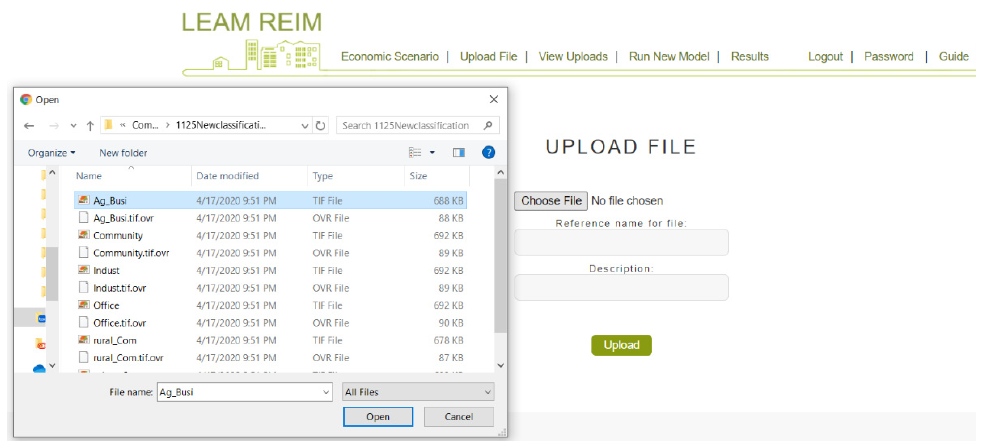
Figure 3. LEAM-REIM interface for uploading files. Users click “choose file” button to choose file from local portals to upload the model input files. A file name and description are required as notes for future use.